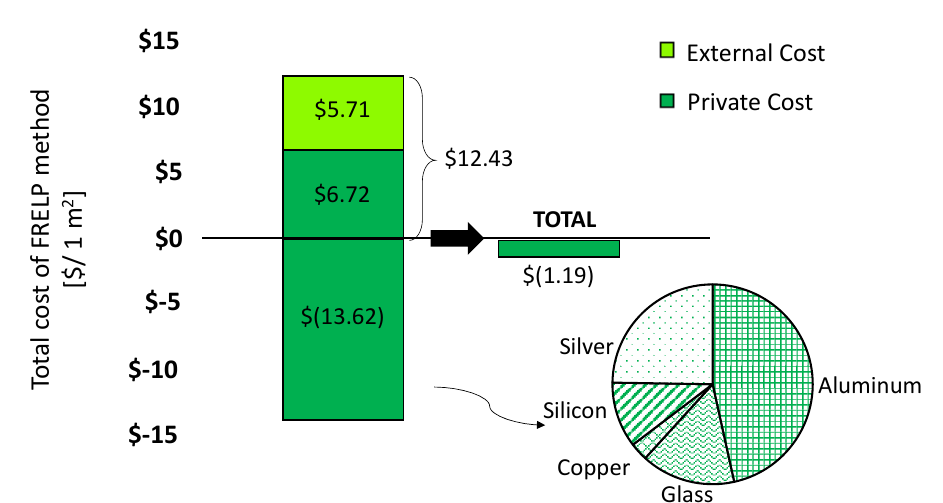
Figure 5. Total cost breakdown of the full recovery end-of-life photovoltaic project (FRELP) method.